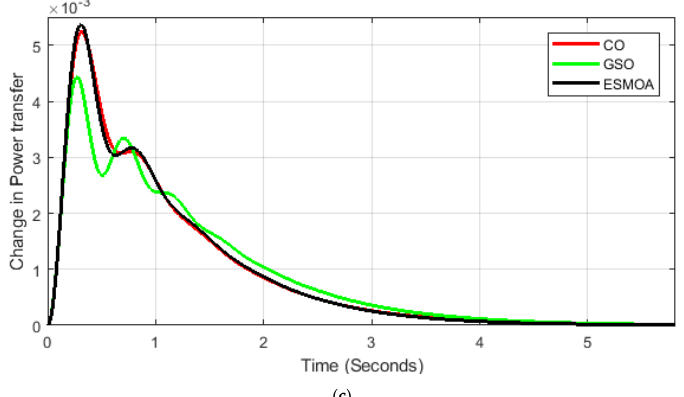
Figure 9. Dynamic responses for CO, GSO, and the proposed ESMOA for Case 2. ( a ) Deviation in frequency in area 1. ( b ) Deviation in frequency in area 2. ( c ) Deviation in transferred power through interconnected tie-line.